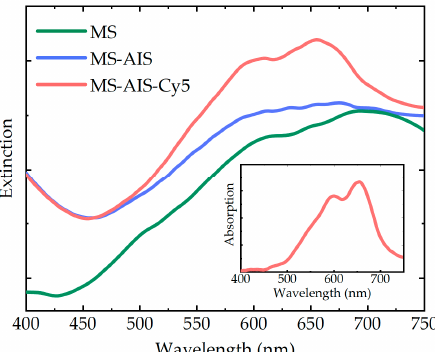
Figure 3. Extinction spectra of MS, PMS-AIS and PMS-AIS-Cy5. Inset: Cy5 absorption is revealed in PMS-AIS-Cy5 after the subtraction of the PMS-AIS background.